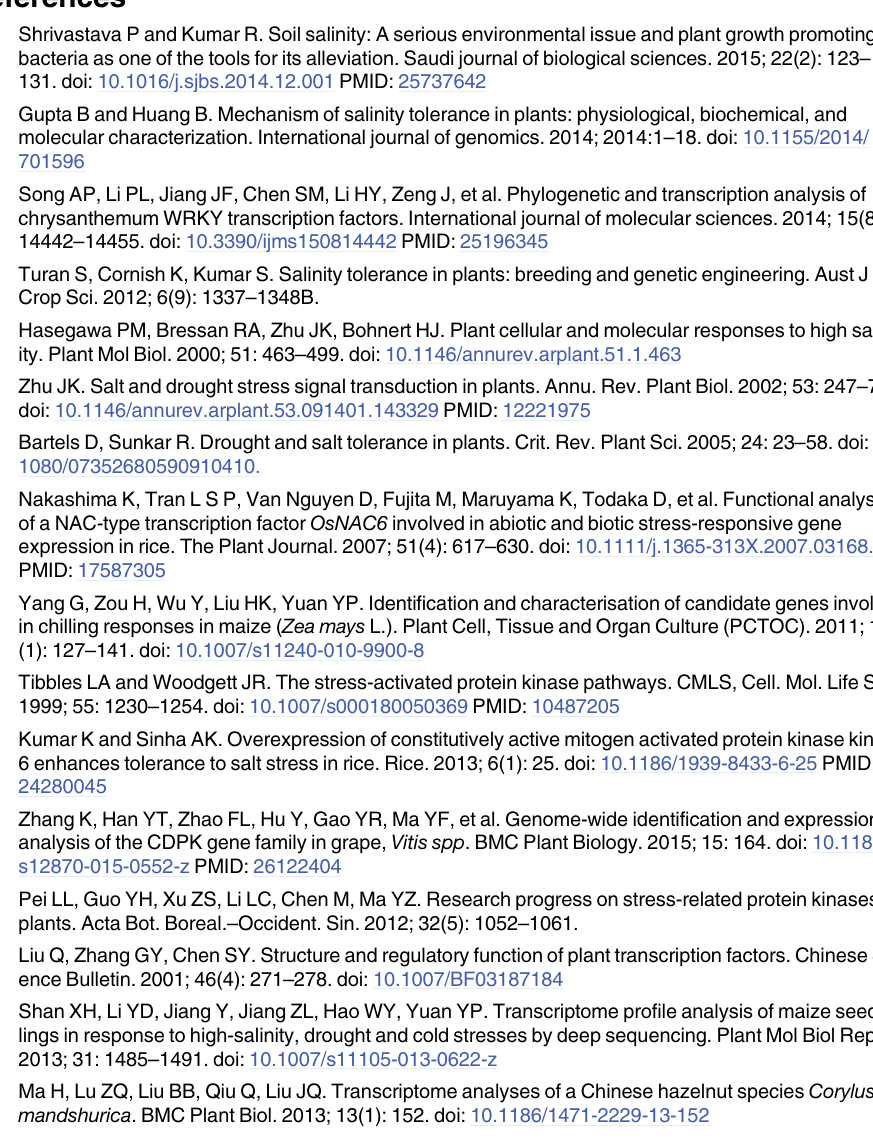
S5 Table. The major differentially expressed transcription factors in chrysanthemum.